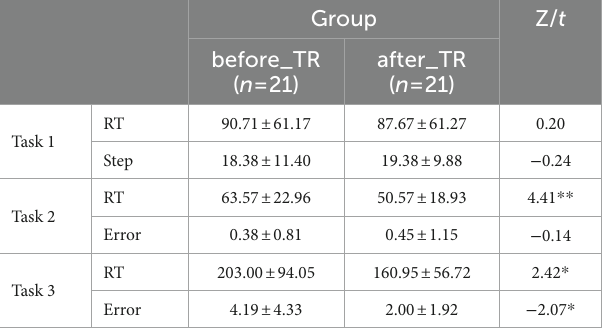
TABLE 3 Behavioral indicators in the cool executive tasks for the before_ TR group and the after_TR group. Group Z/